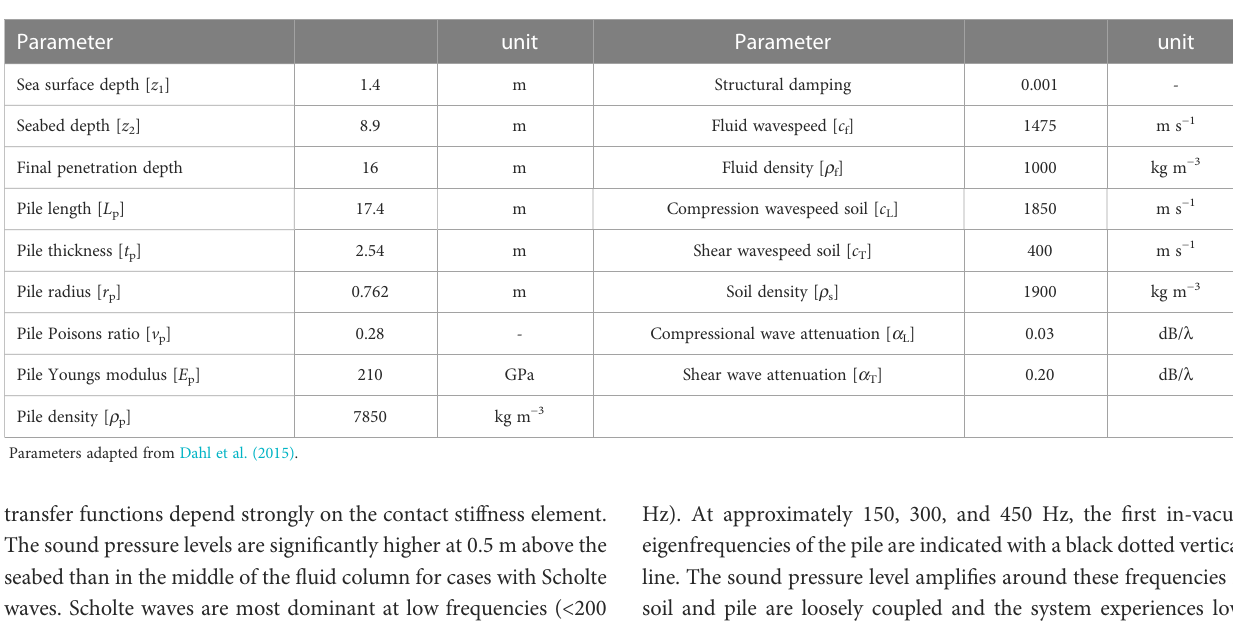
TABLE 2 Model properties used to examine the effect of pile-soil interface conditions based on parameters in Section 5.